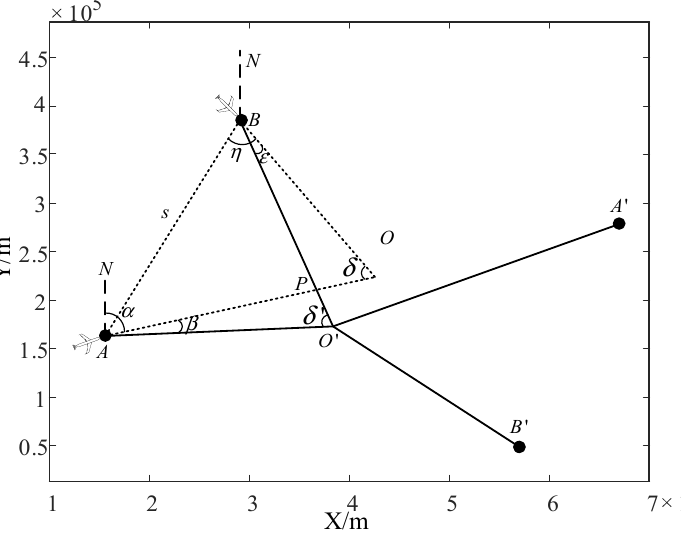
Figure 4. Horizontal cross-conflict scenario.